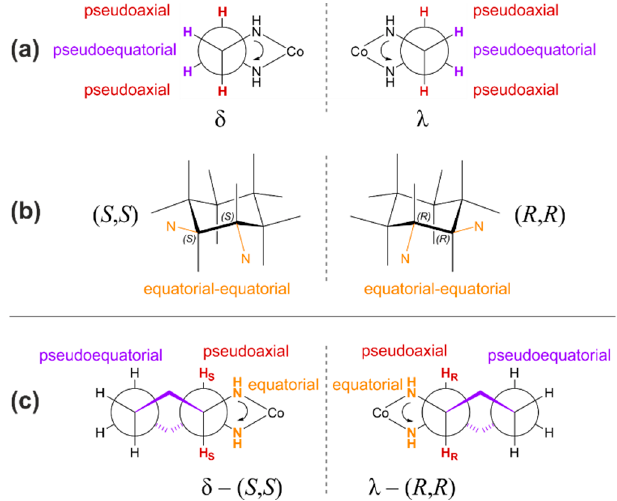
Figure A2. Panel (a): Alternative conformations for a twist isomer of five ‐ membered ring in salen ‐ type complexes. Arrow depicts the direction of the measured angle—positive value of angle corresponds to the λ conformer, while the δ conformer is characterized by negative angle value. Panel (b): Configurational ( S , S ) and ( R , R ) isomers of 1,2 ‐ cyclohexanediamine. Panel (c): Chelate conformation of trans ‐ 1,2 ‐ cyclohexanediamine ligand, presented as a Newman projection along CH 2 ‐ CH 2 bonds of cyclohexane ring. Arrow depicts the direction of the measured angle. H S / H R label indicates hydrogen atom connected to asymmetric carbon atom of S / R configuration.